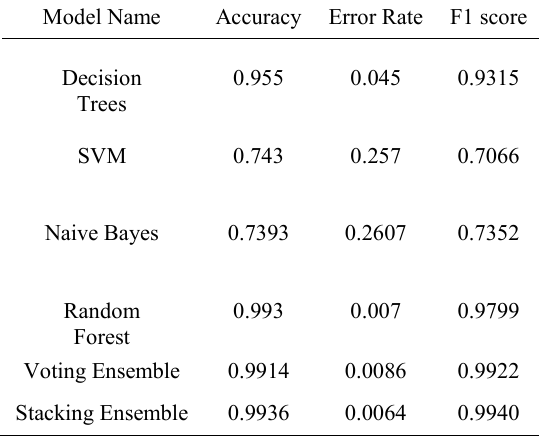
Table 6. Metrics Used for Performance Evaluation of Regression